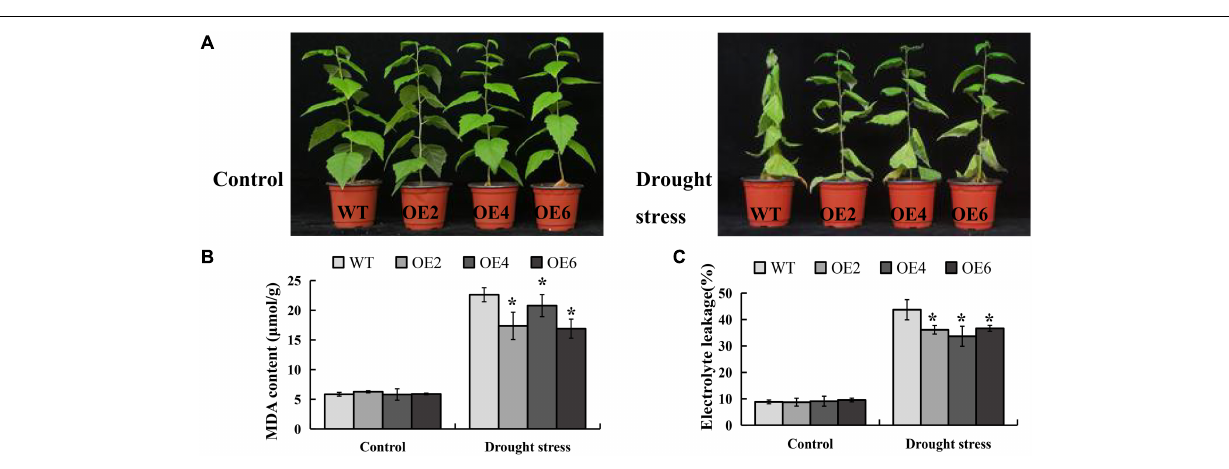
FIGURE 5 | Overexpression of BpLEA14 conferred enhanced drought tolerance in its transgenic lines. (A) Phenotypic comparison of BpLEA14 overexpression ( BpLEA14-OE ) transgenic lines and wild-type (WT) plants under drought stress. (B) Content of malondialdehyde (MDA). (C) The result of electrolyte leakage. Asterisks indicate significant differences by t -test, p <